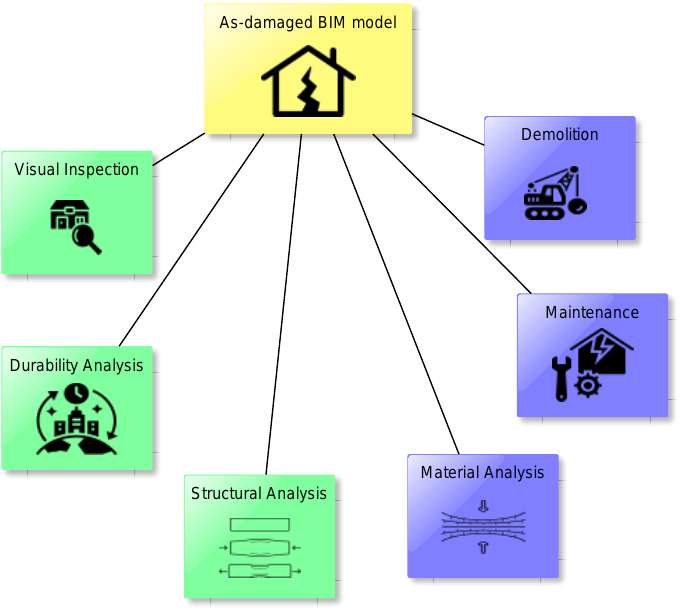
Figure 1. The as-damaged BIM model as a central point for involved domains during the operation phase. Pictograms have been taken from the Noun Project